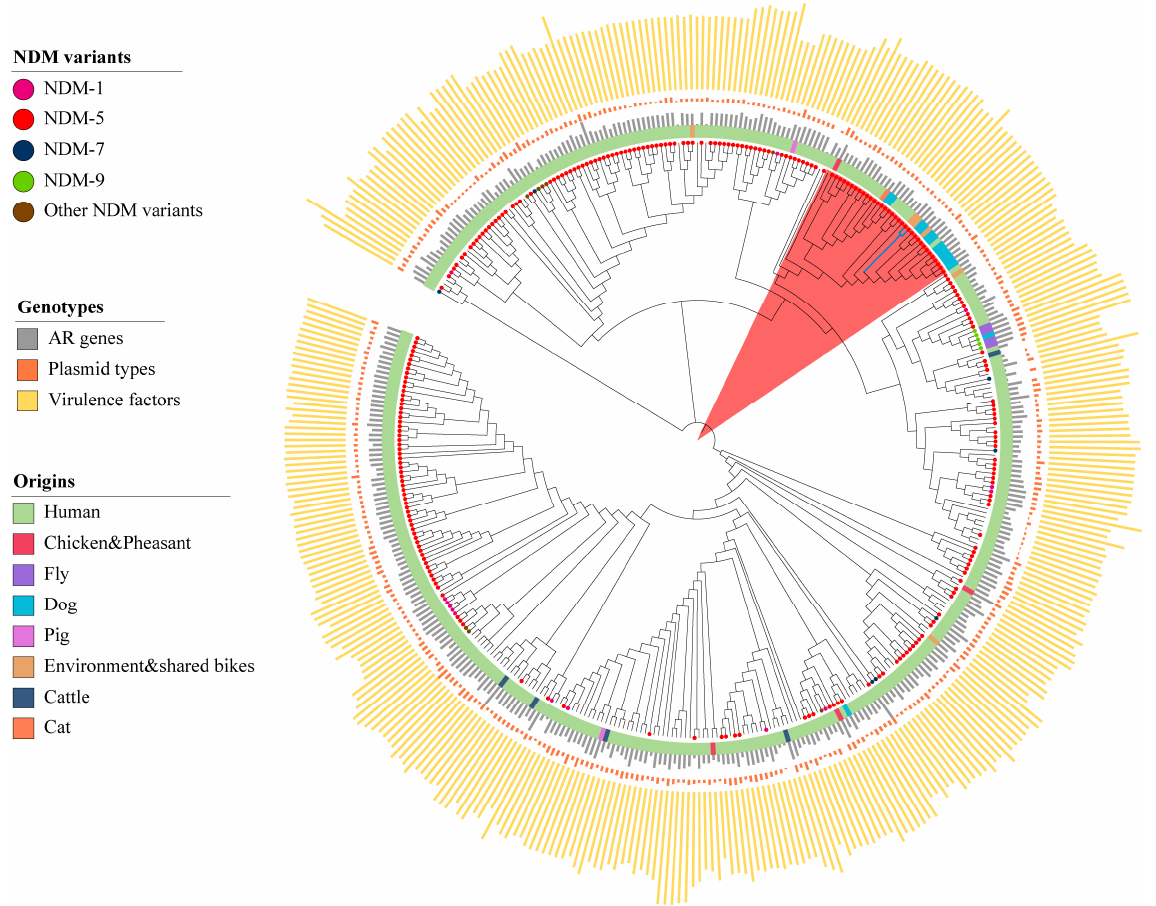
Figure 3. The core genome phylogenetic tree of ST167 E. coli from humans, animals and the envi- ronment. (The blue branches are the strains from shared bikes, the length of the bar represents the number of ARGs/Plasmid types/Virulence factors. The circles attached to the leaves represent the NDM variants).